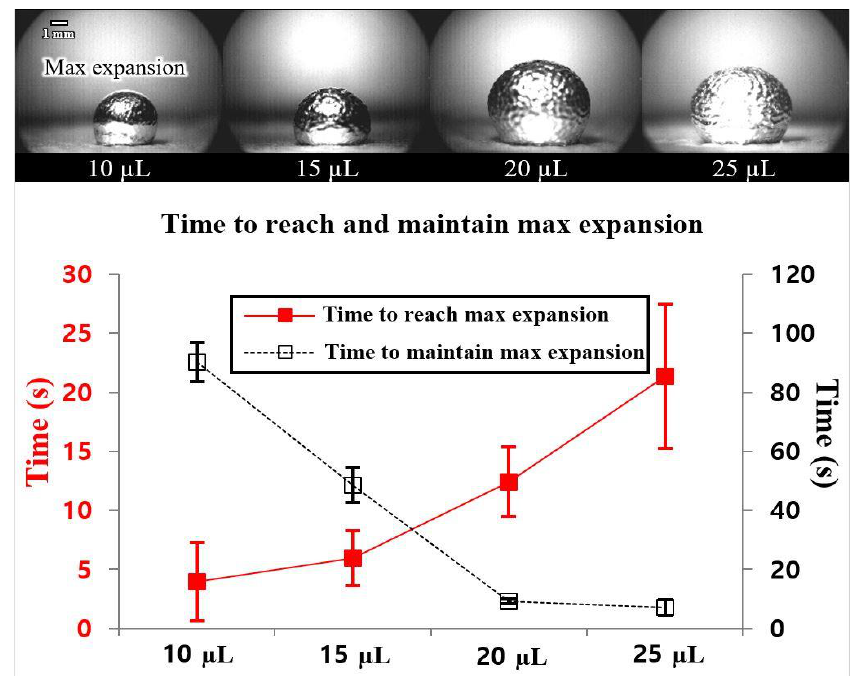
Figure 5. The time needed to reach and maintain maximum expansion, depending on the size of the liquid metal droplet.